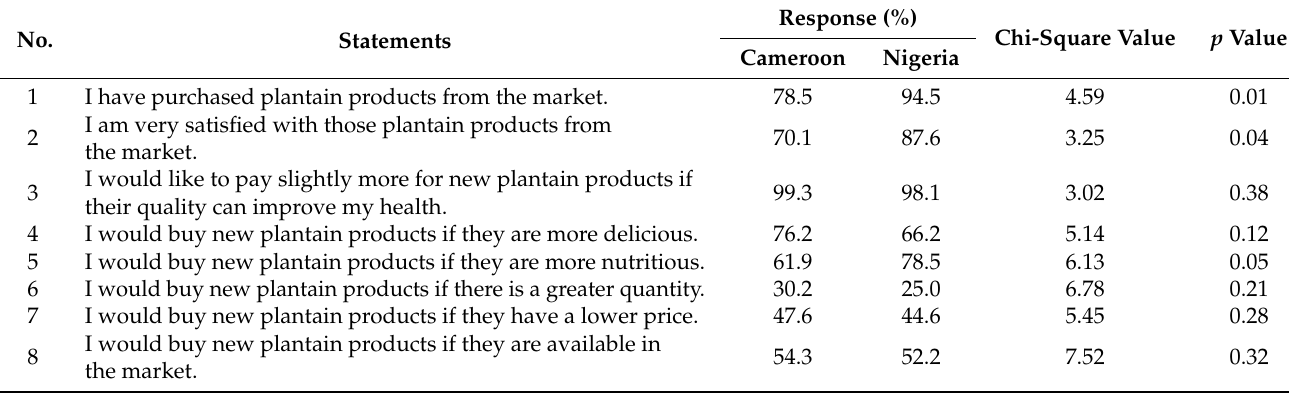
Table 6. Respondents’ satisfaction and attitude responsible for plantain